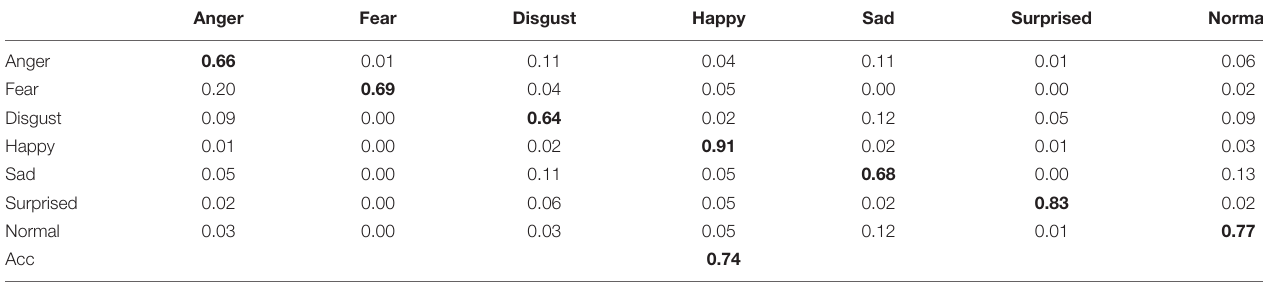
TABLE 2 | Confusion matrix of recognition rate on FER-2013 dataset. Anger Fear Disgust Happy Sad Surprised Normal